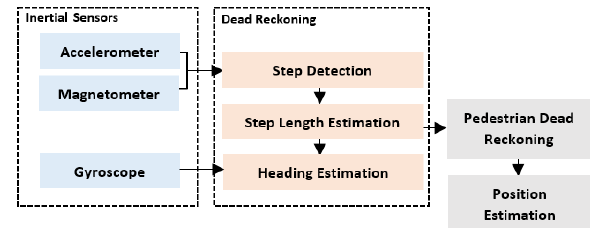
Figure 2. Pedestrian Dead Reckoning principle